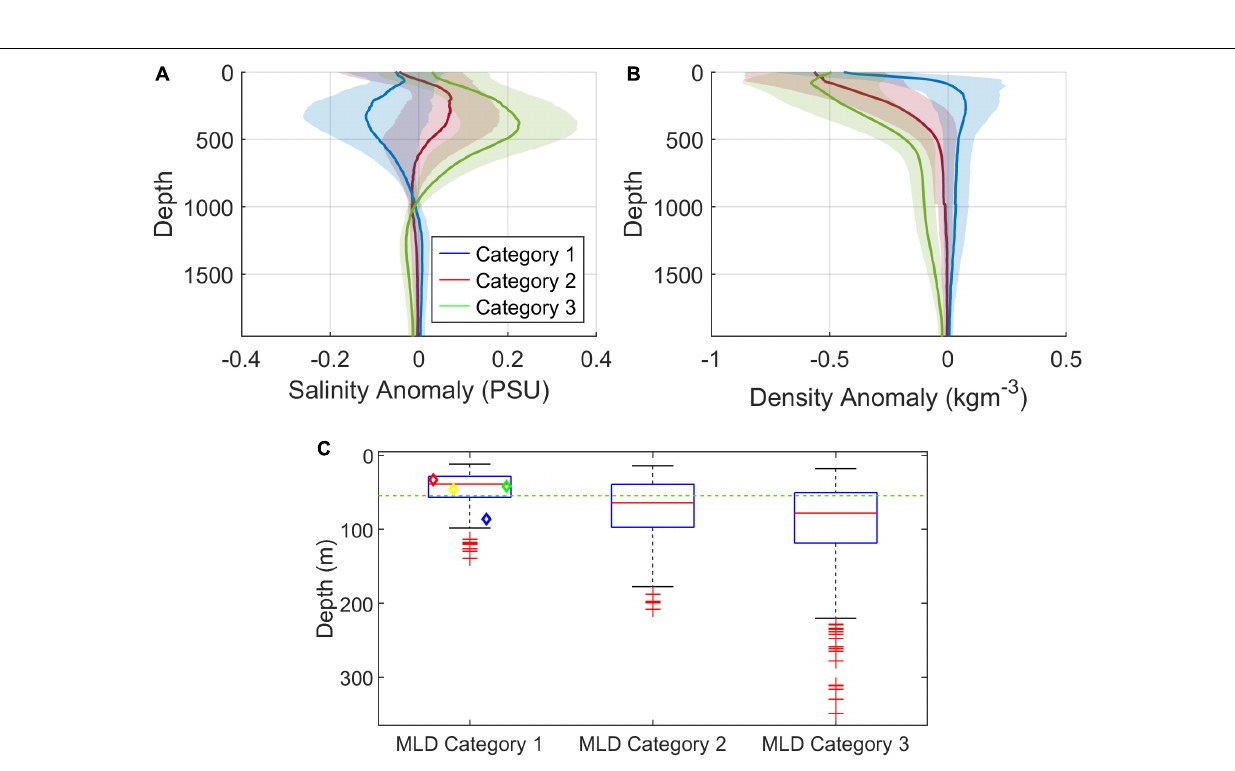
Frontiers in Marine Science |